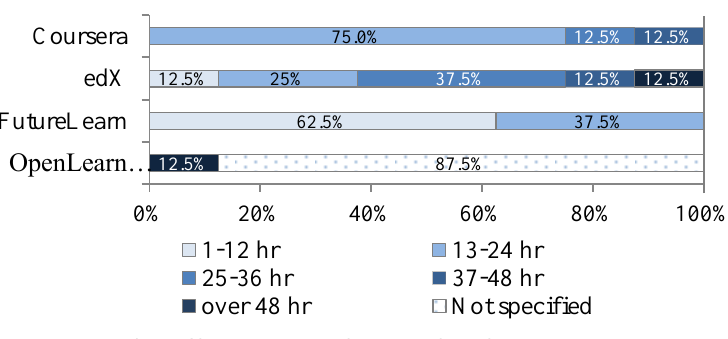
Figure 1 Number of hours expected to complete the